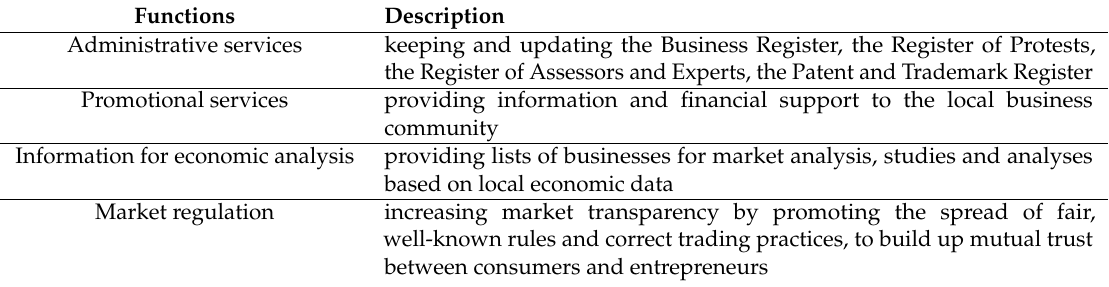
Table 1. Main functions of Italian chambers of